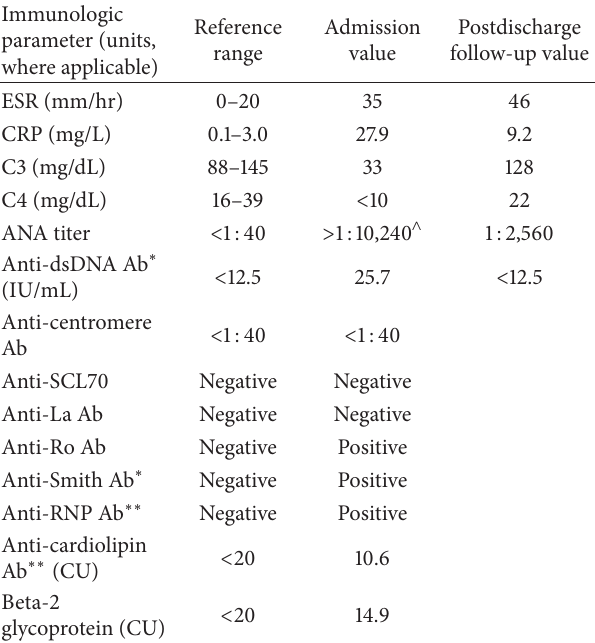
Table 2: Laboratory assessment of immunologic and inflammatory disease activity at admission and at follow-up 8 weeks later showing serologic phenotype and response to therapy.